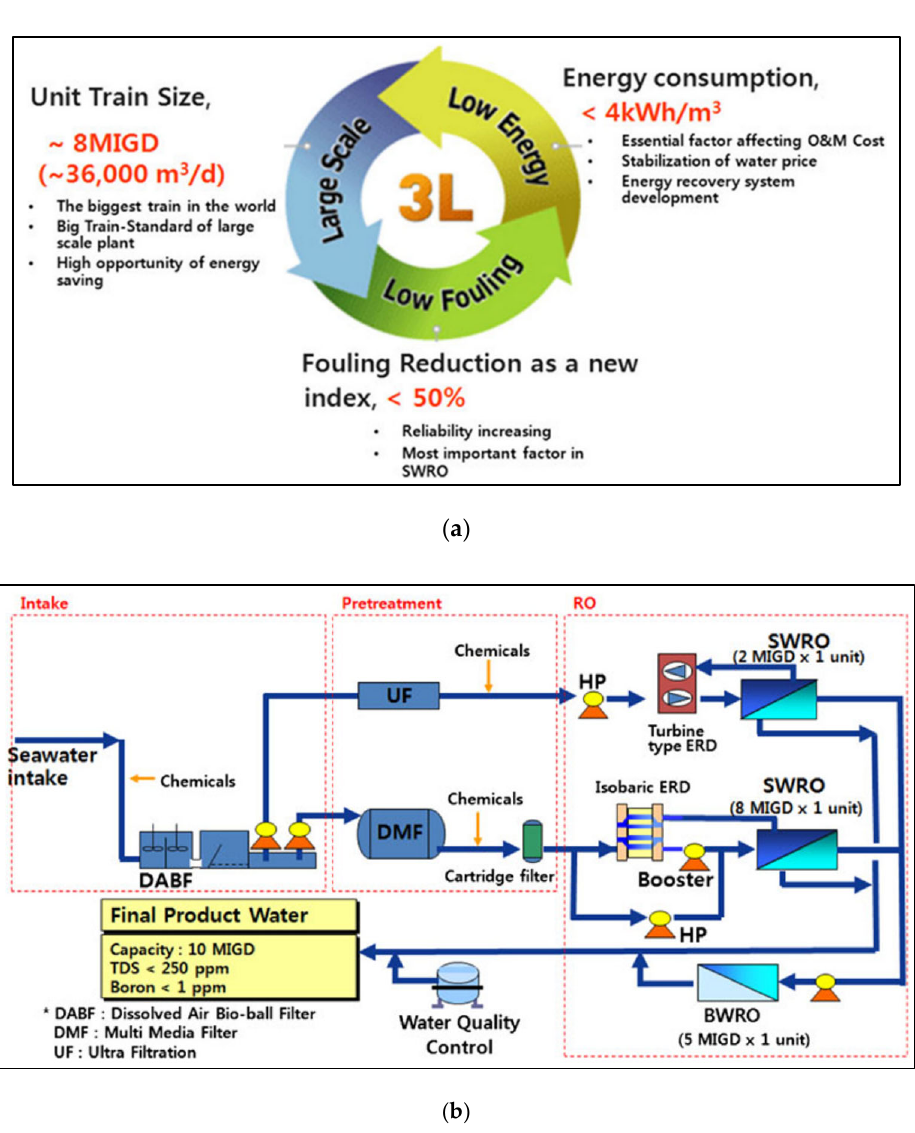
Figure 4. ( a ) The three main strategies in the seawater engineering and architecture of high-efficiency reverse osmosis (SEAHERO) research and development program and ( b ) the flow diagram of the SEAHERO testbed [28] .